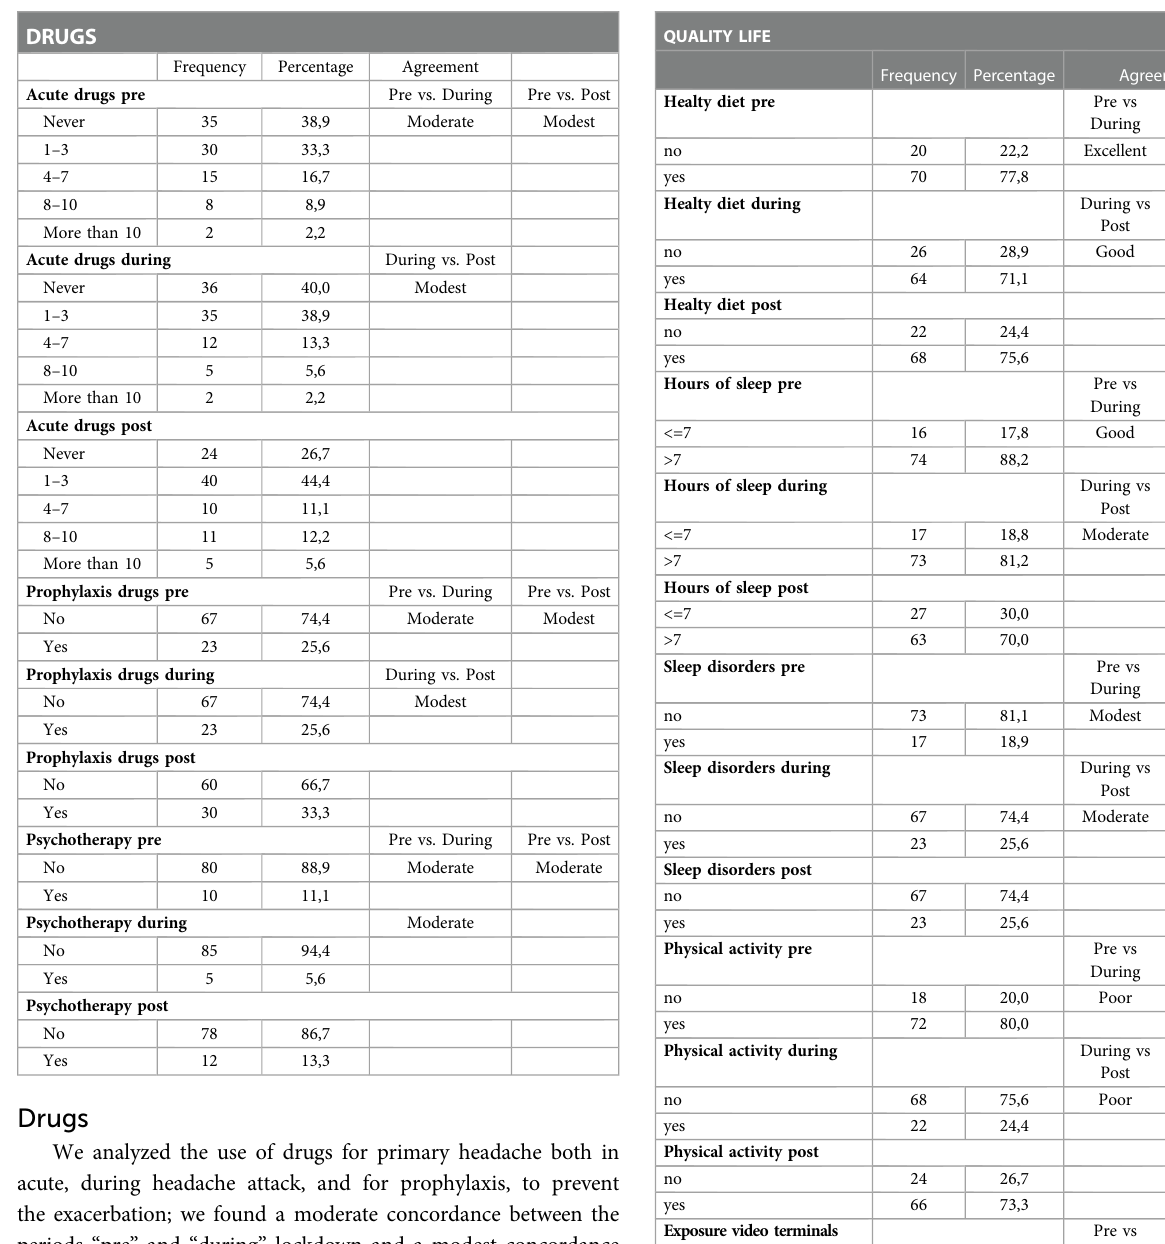
TABLE 5 Concordance analysis about drugs. Table 6 Concordance analysis about Quality